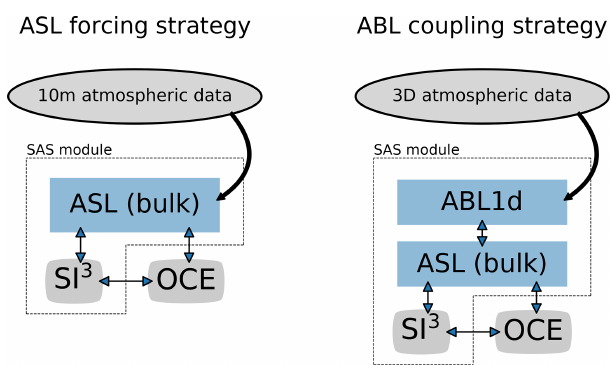
Figure 3. Schematic representation of the ASL forcing strategy (left) and ABL coupling strategy (right) in terms of code orga- nization and required external data. The OCE and SI 3 compo- nents represent the oceanic and sea-ice dynamics and thermody- namics respectively while the ASL component is in charge of pro- viding boundary conditions related to atmospheric conditions. In the NEMO computational framework the so-called surface module (SAS component), delineated by dashed line polygons, is virtually separated from the OCE component, which allows SAS to be run in standalone or detached mode (see Sect.